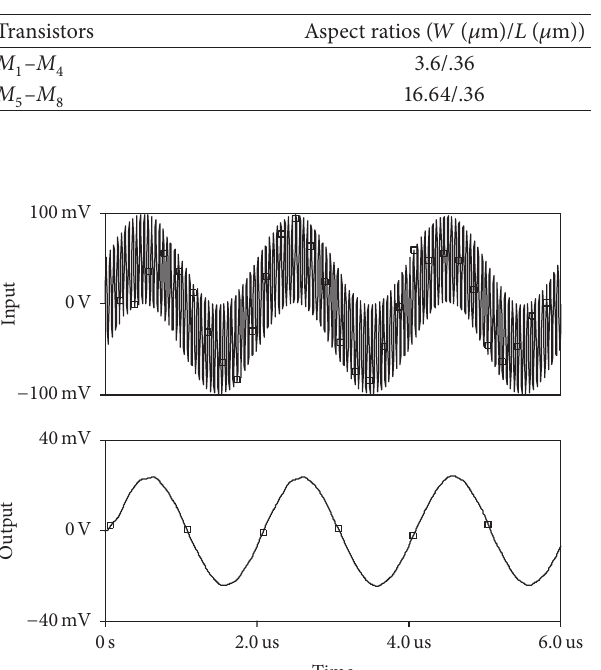
Table 1: Aspect ratio of various transistors used in CMOS imple- mentation of VDTA.